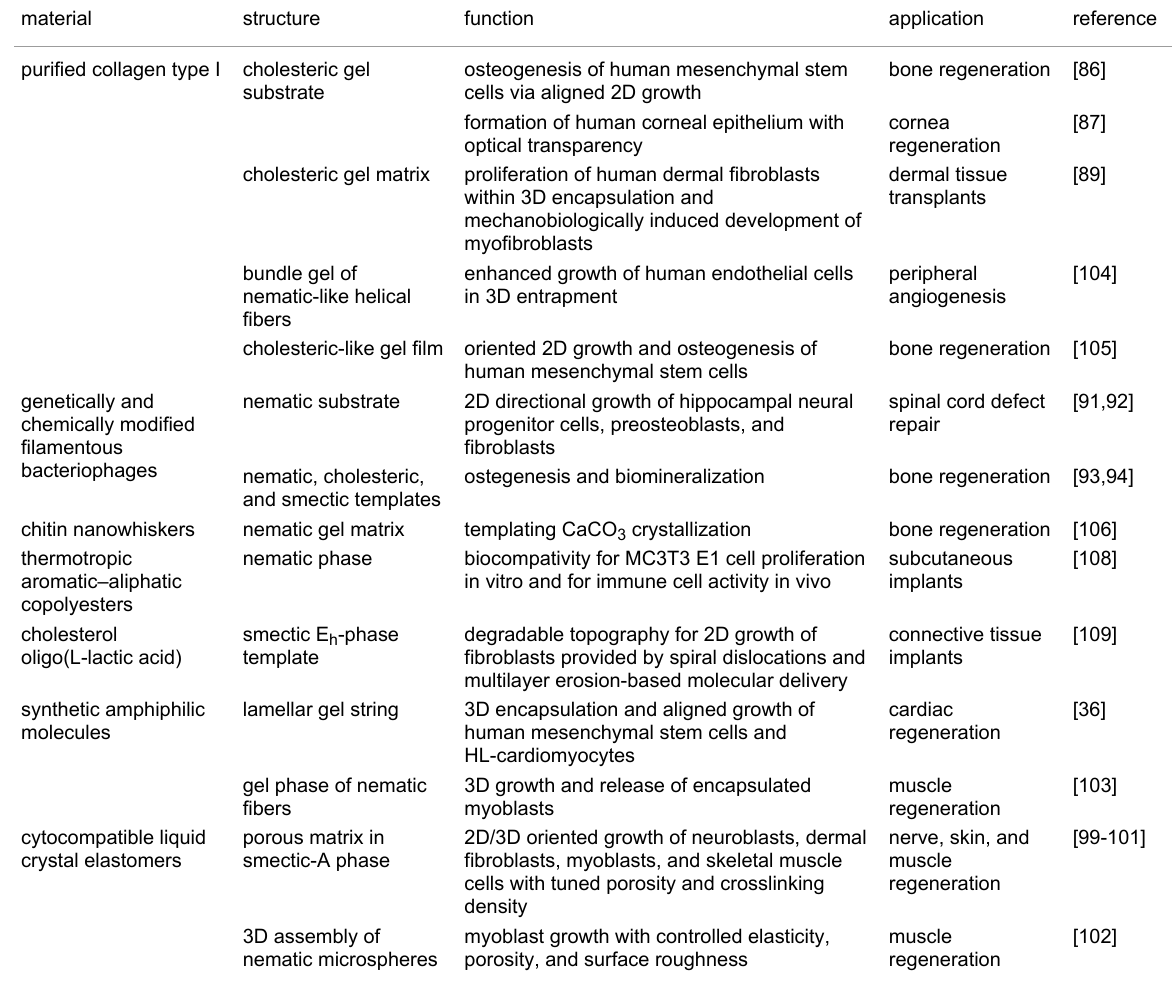
Table 1: Summary of examples on liquid crystalline templates and scaffolds for tissue engineering